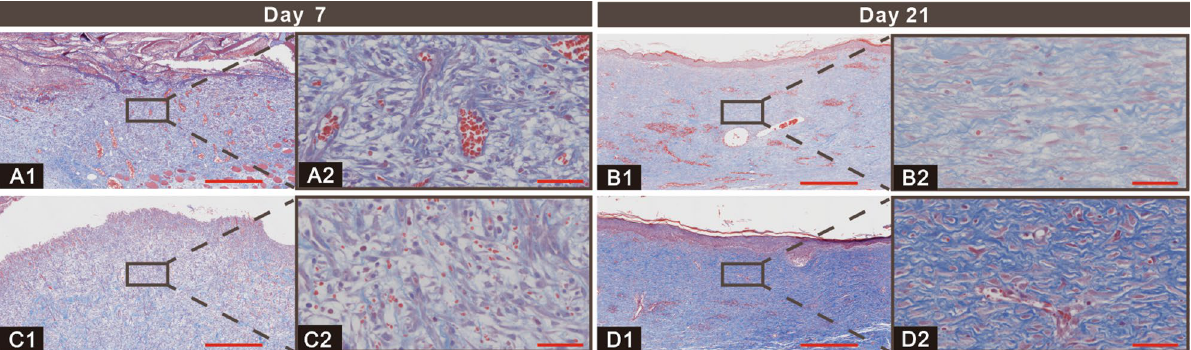
Figure 5. Representative images of the Masson’s trichrome staining on the day 7 and 14 ( A , B represent rcBCS group and C , D represent sham operation group; Bar in 1 = 500 μm, bar in 2 = 50 μm).